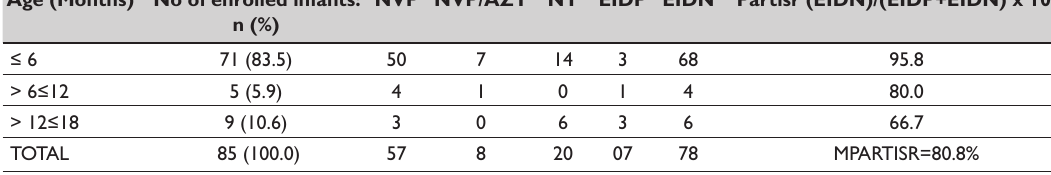
Table 4: Age group at first visit and paediatric antiretroviral interventions success rates in HIV‑exposed infants/children Age (Months) No of enrolled infants: n